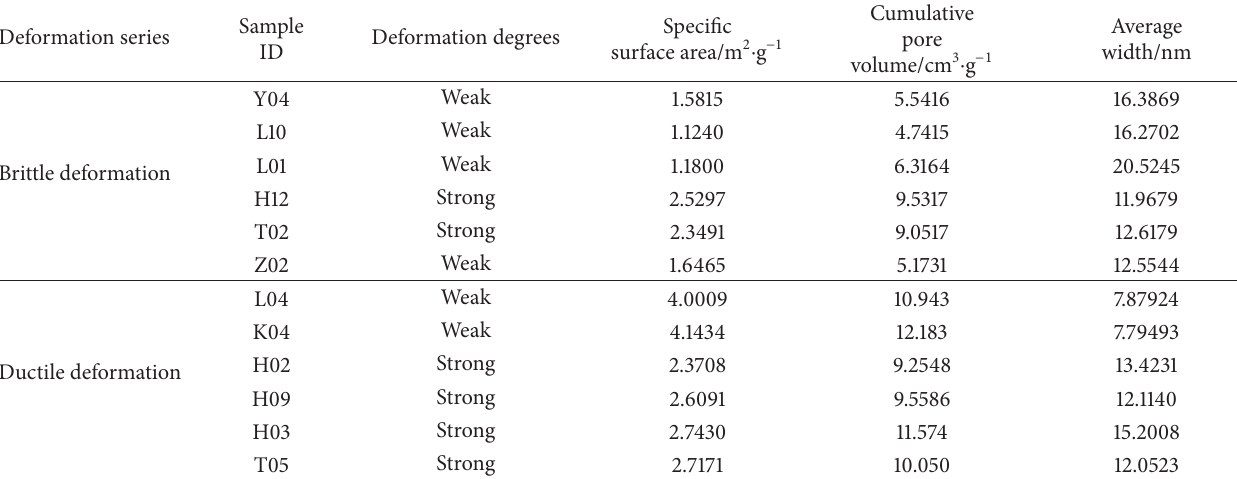
isotherm for deformed coal samples. 2